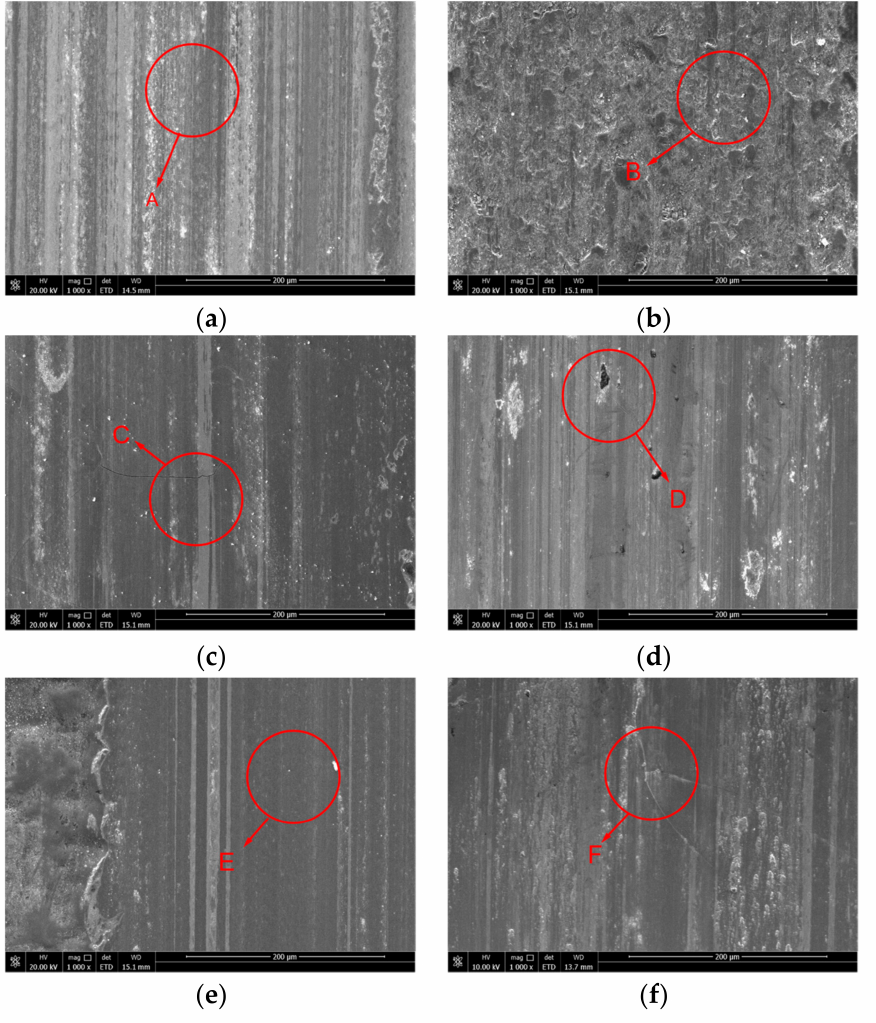
Figure 9. Surface morphology of wear marks. ( a ) 30 A · dm − 2 (J) ( b ) 20 A · dm − 2 ( c ) 30 A · dm − 2 ( d ) 40 A · dm − 2 ( e ) 50 A · dm − 2 ( f ) 60 A · dm − 2